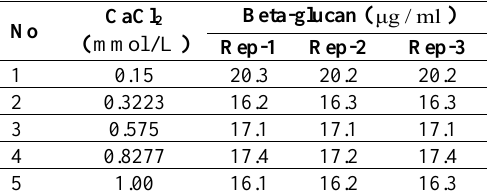
Table 4. Data set for CaCl 2 and BG.